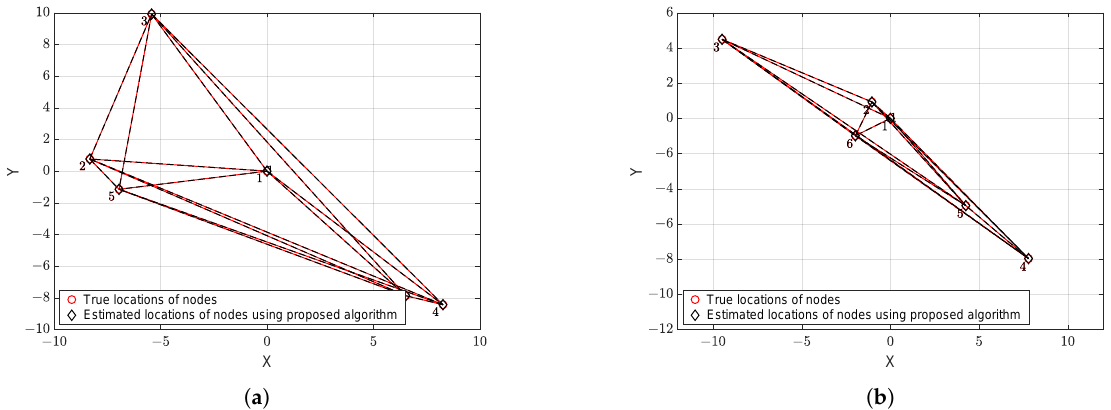
Figure 3. Estimation of the positions of nodes in noise-free scenarios. ( a ) Rotation only; and ( b ) Rotation and